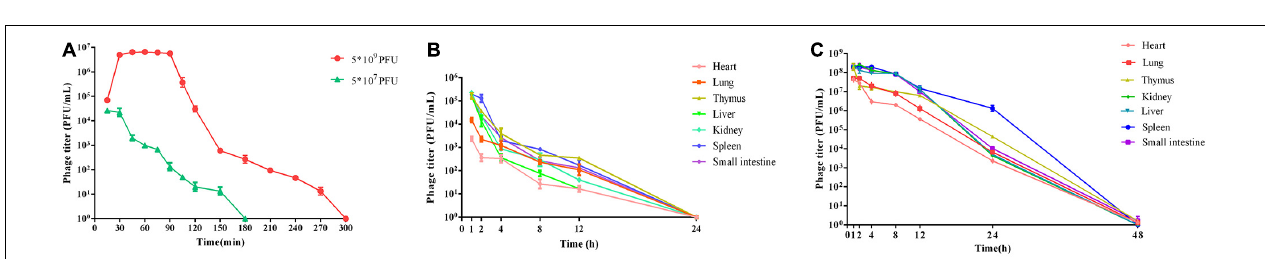
FIGURE 5 | Metabolism in mice after injection with phage vB_Kox_ZX8. (A) Phage titer in the blood after mice were injected with 5 × 10 7 PFU and 5 × 10 9 PFU of phage vB_Kox_ZX8; phage titer in different organs after phage vB_Kox_ZX8 injection at (B) 5 × 10 7 PFU, (C) 5 × 10 9